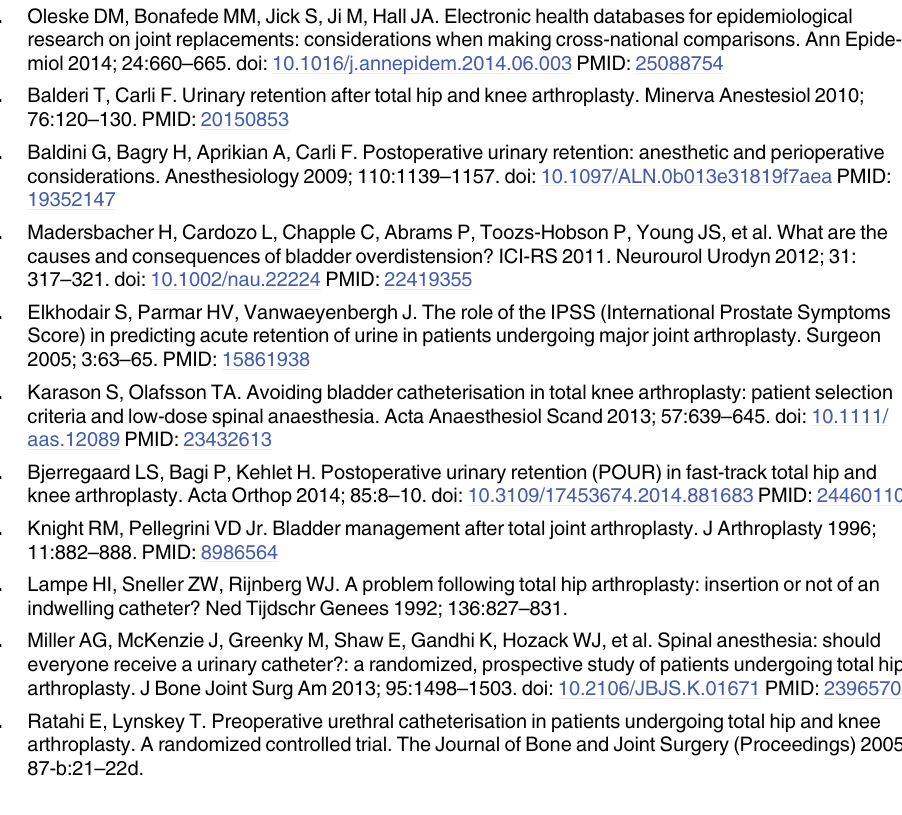
S2 Table. Meta-regression for variables that influence the association for the pooled results of